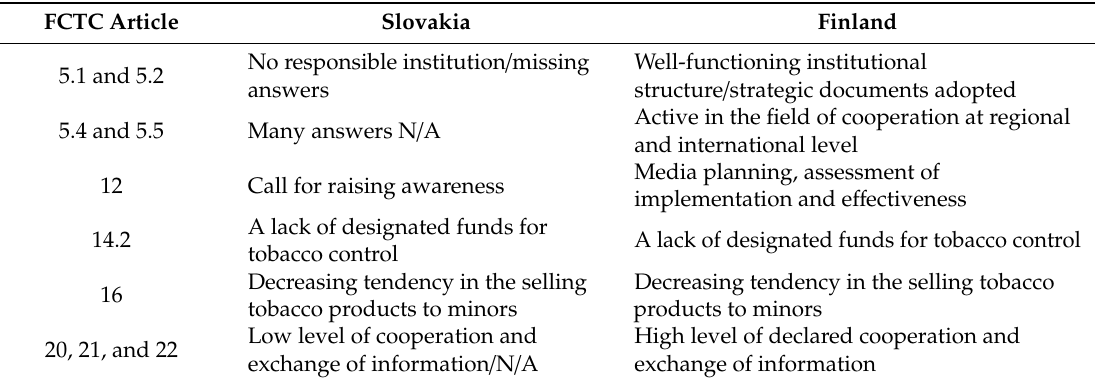
Table 3. Implementation of the Framework Convention on Tobacco Control (FCTC) articles in Slovakia and in